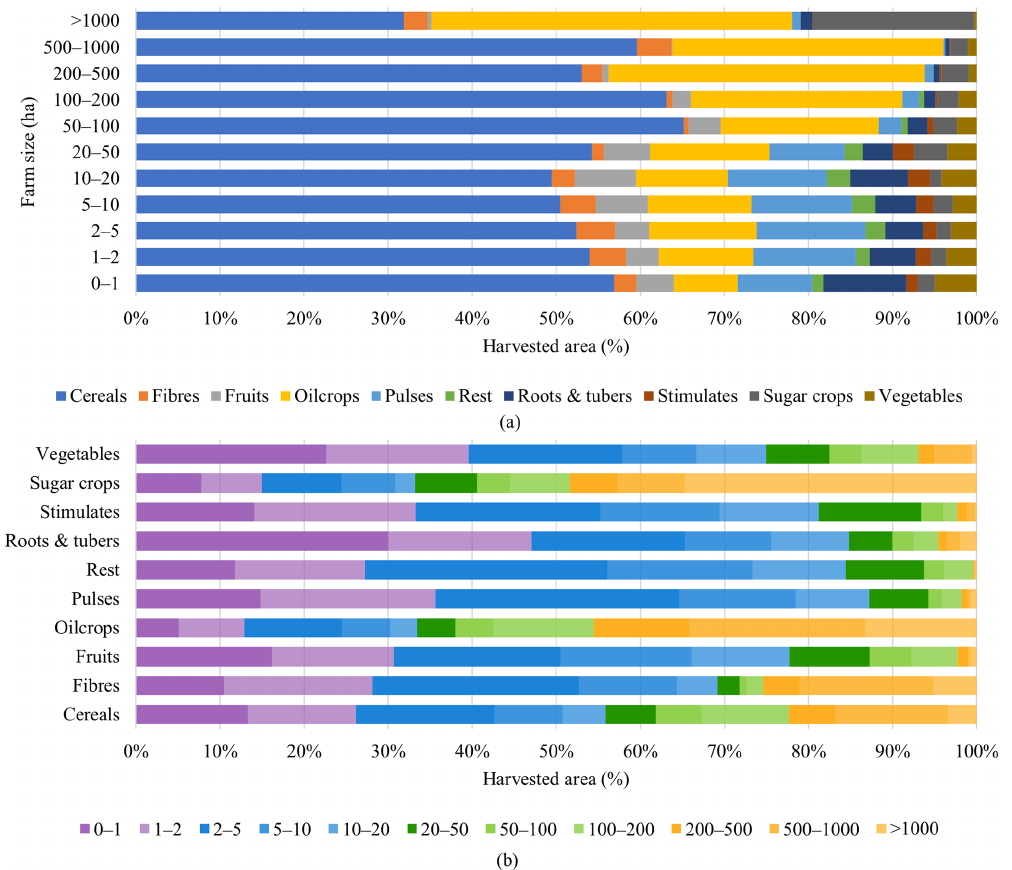
Figure A2. Harvested area of crop groups within each farm size (a) and harvested area of crop groups by farm size (b) according to our farm-size-specific and crop-specific harvested area datasets based on the SPAM2010 crop map. The alternative version based on GAEZv4 crop map is given in Fig. 3.